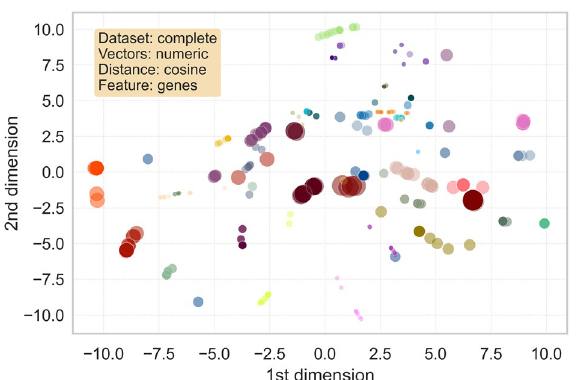
Figure 3. Visualization of the first analysed model obtained performing OPTICS. Each point represents a disease, plotted in the two-dimensional space obtained once applied PCA and t-SNE to the genes feature matrix related to the complete set of diseases. Different colours symbolize different clusters. The size of the points ranges accordingly to the clusters’ size. Only diseases in clusters containing more than 10 diseases have been represented for the sake of clarity (a total of 468